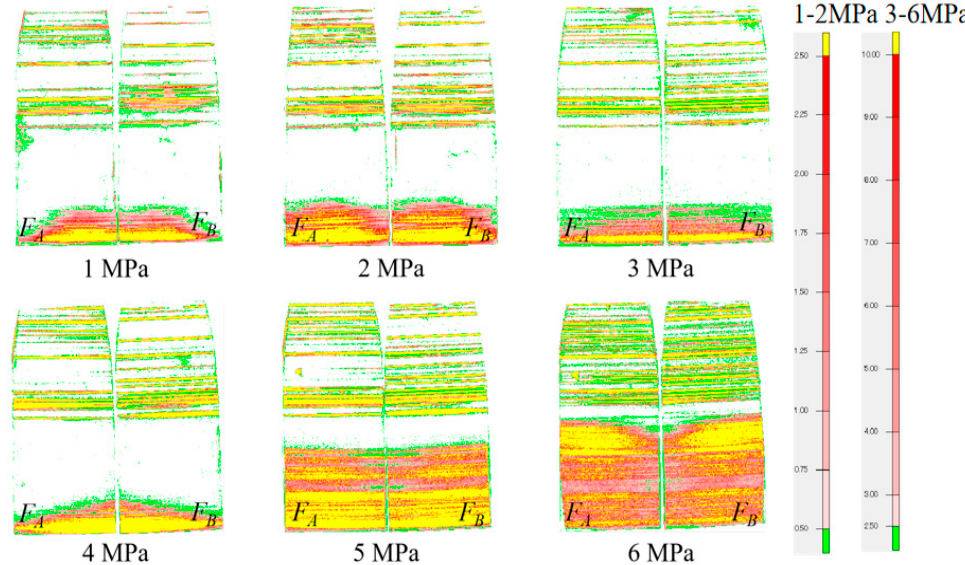
Figure 6. Compression performance of pressure film under different pressures.